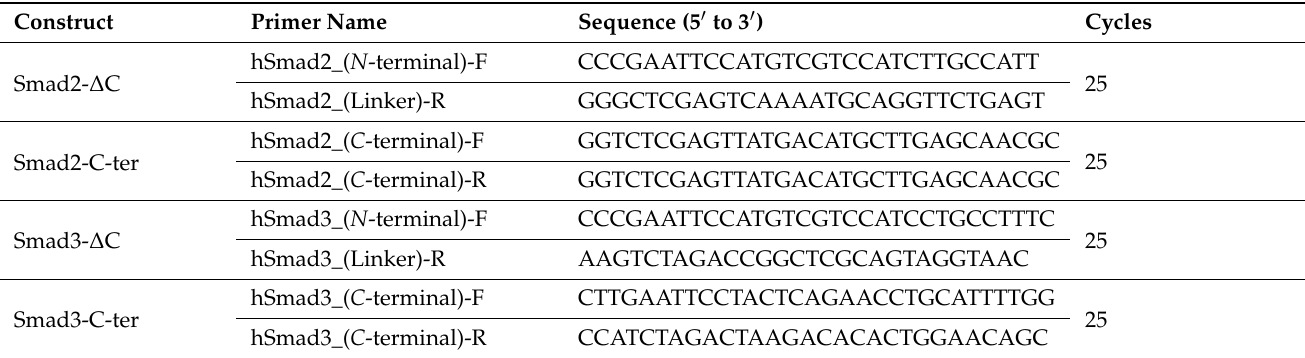
Table 3. Primers used for truncated hSmad2 and hSmad3 protein constructs.